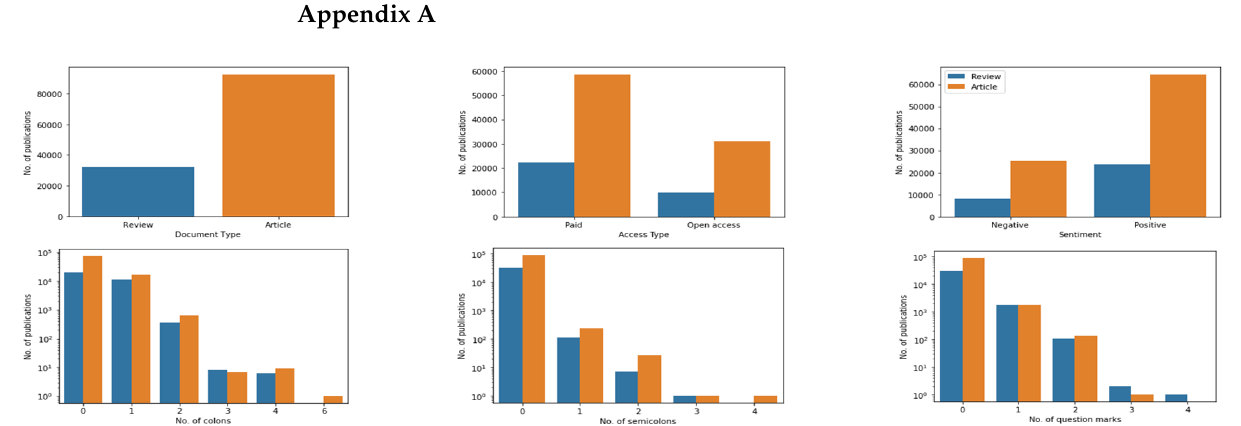
Figure A1. Composition of our dataset. Above: number of reviews and original articles ( left ), number of open access or subscription papers ( middle ), number of publications with negative or positive title sentiment score ( right ). Below: number of publications by colon number in the title ( left ), by semicolon ( middle ) or by number of question marks ( right ). All the publications are stratified according to document type, where blue indicates reviews and orange indicates original articles.